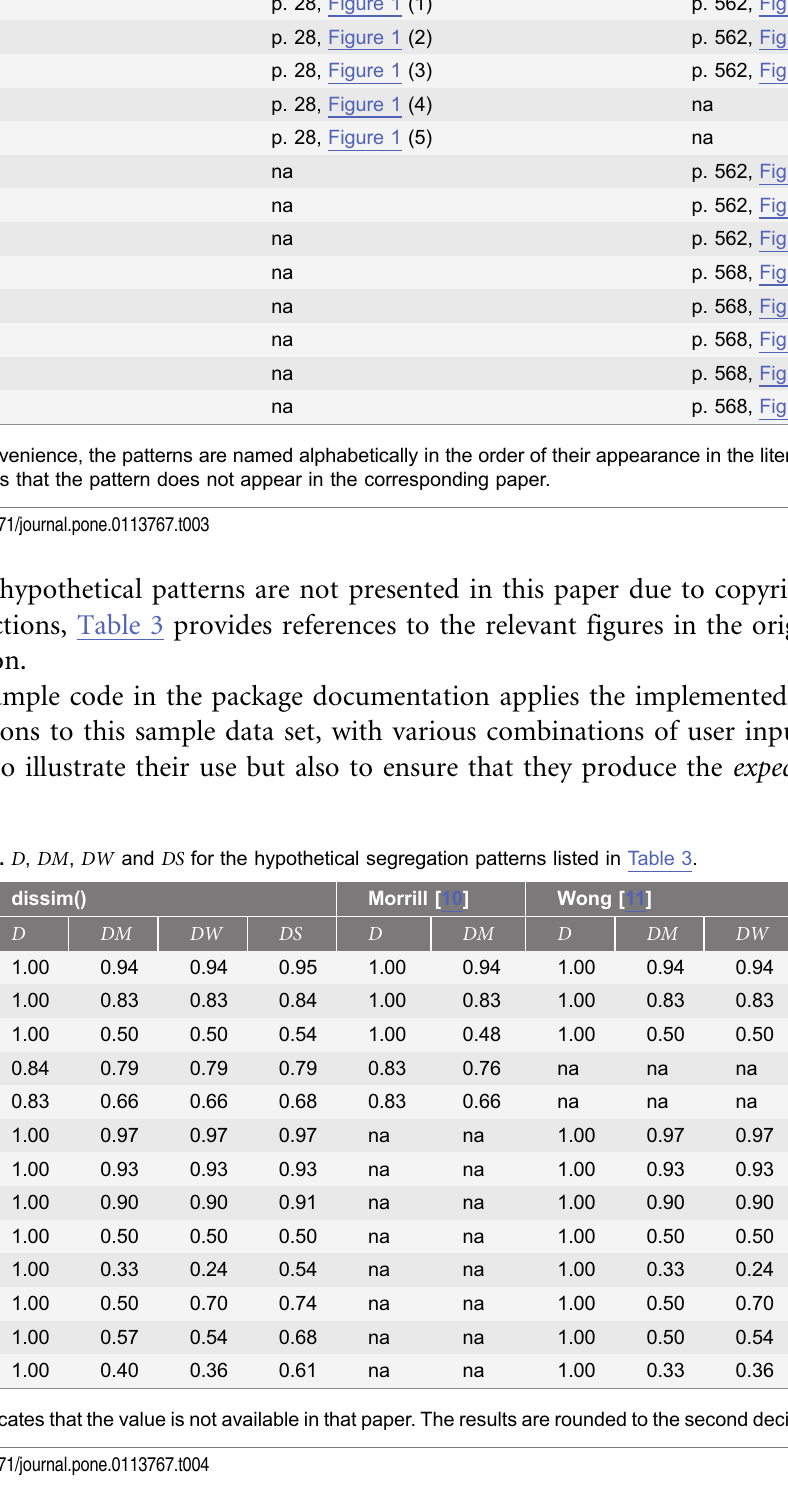
Table 3. A list of hypothetical segregation patterns adopted in this paper and their original citation. Pattern